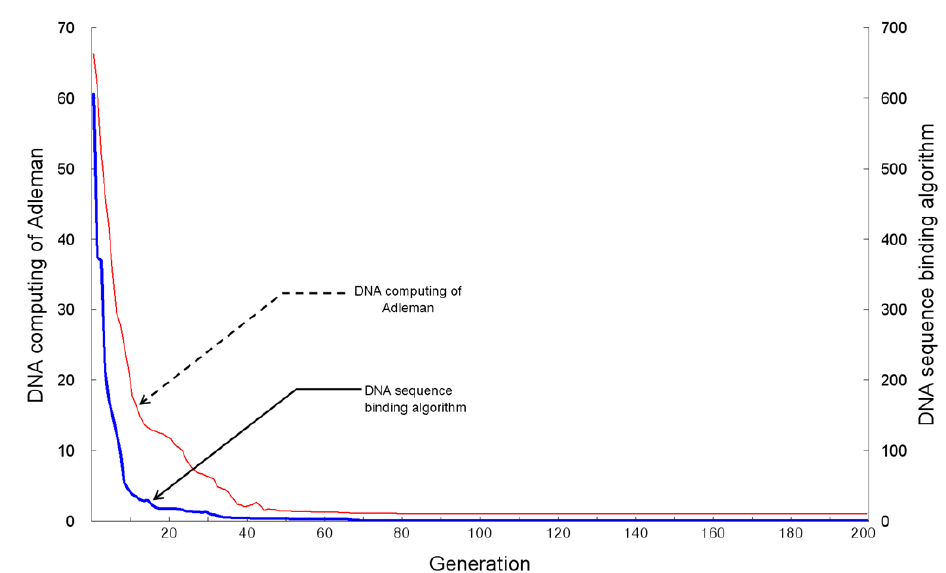
Figure 7. Search number for ten